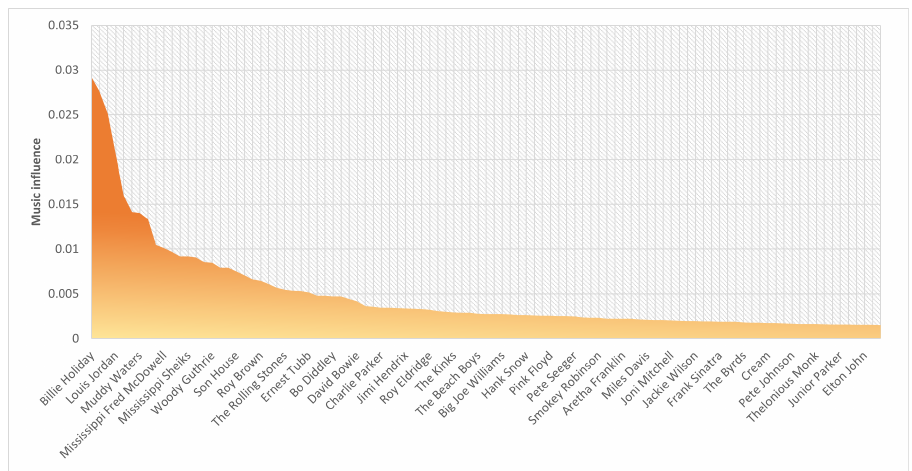
Figure 3. Top musicians’ influence